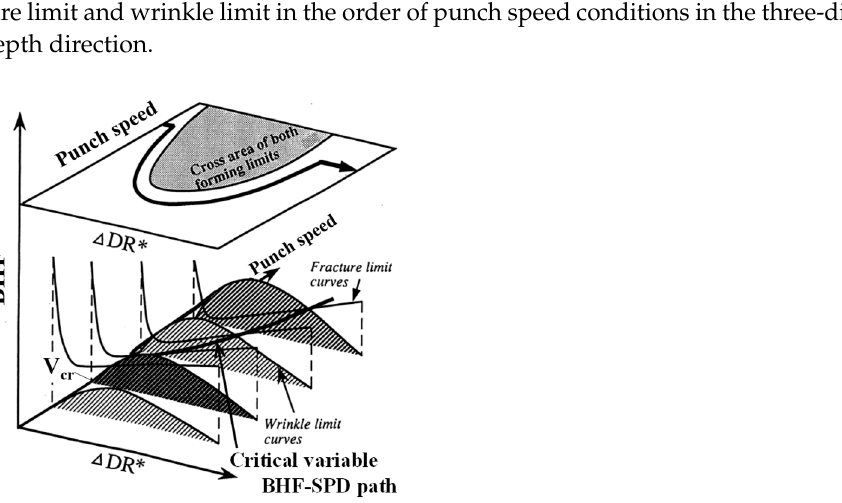
Figure 11. Schematic concept of critical variable BHF and SPD method in three dimensional BHF– SPD– ∆ DR* space for warm deep drawing of strain rate-dependent materials. V cr : critical punch speed at constant punch speed condition.